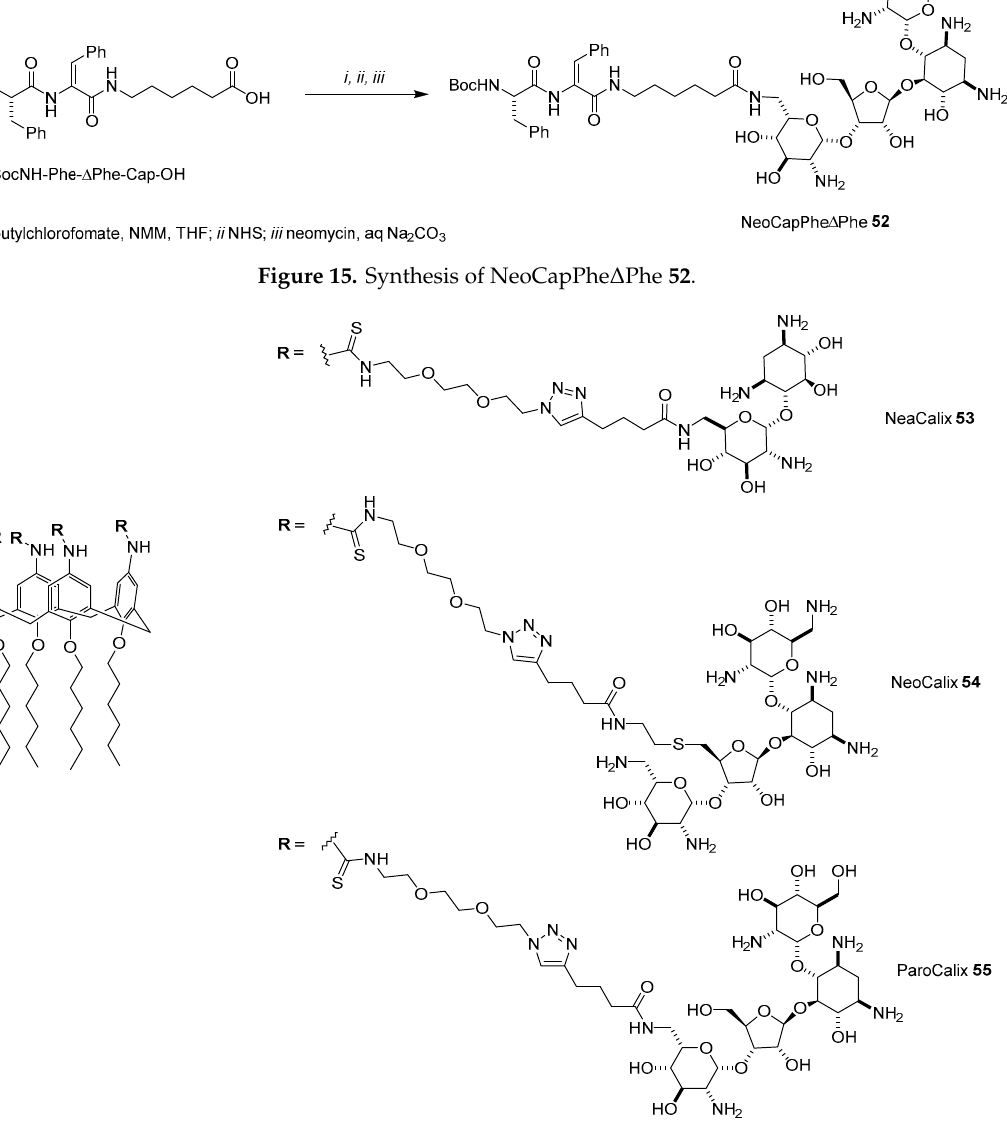
Figure 16. Structures of AG-calix[4]arene conjugates 53 – 55 .